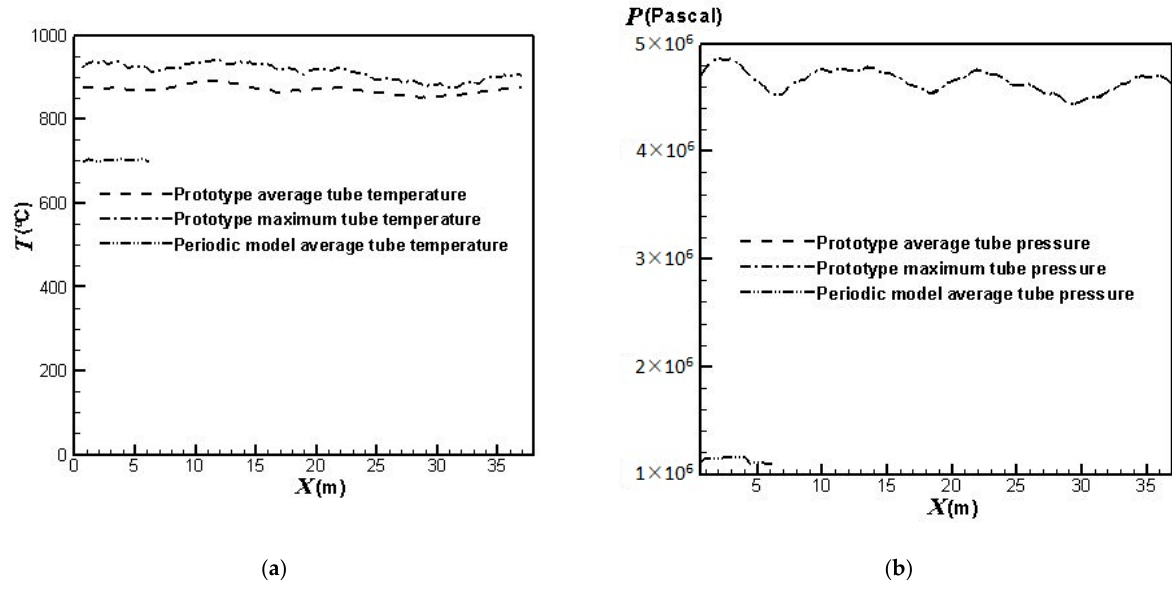
Figure 4. Outer surface temperatures and inner surface pressures of the catalyst tubes: ( a ) Temperatures; ( b ) Pressures.